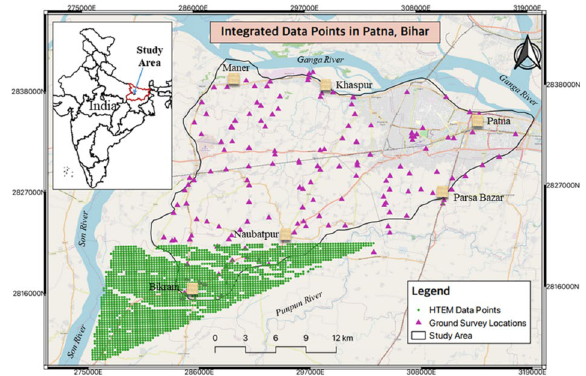
Figure 1. Study area showing the survey points of ground geophysics and HTEM in a part of Ganga basin, Patna, Northern India (N.C.M.: sketched this figure with the help of ArcGIS Desktop 10.7, http:// www. esri.